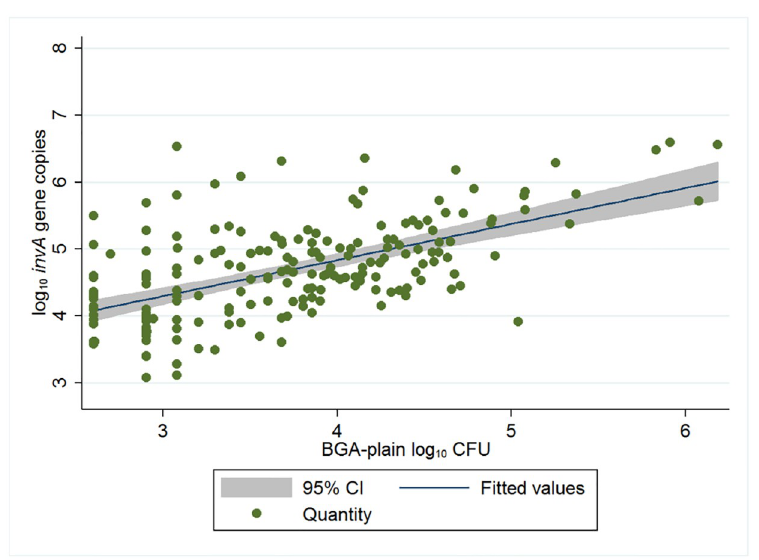
Fig 1. Linear prediction line and scatter plot of quantities of log 10 invA genes via qPCR and log 10 CFU on BGA- plain agar. Only with samples quantified using both methods (n = 190). The R 2 was 0.43, the coefficient was 0.54 and the intercept was